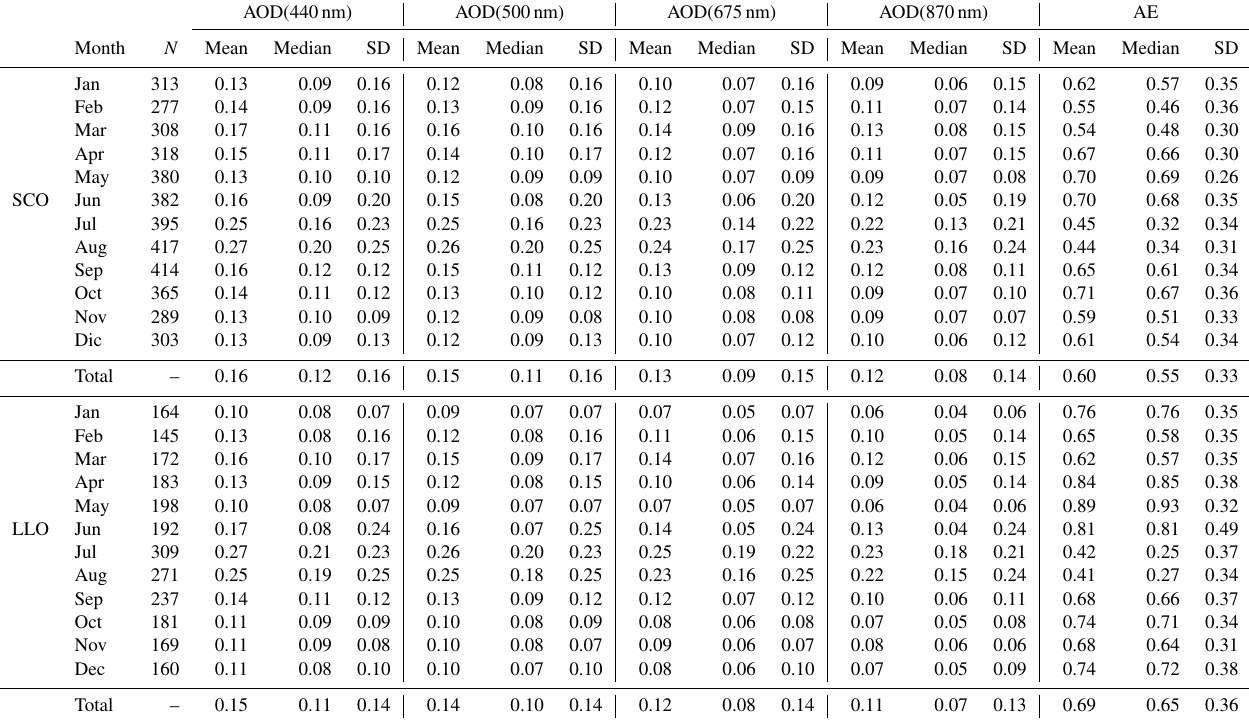
Table A1. Monthly mean, median and standard deviation (SD) of the aerosol optical depth (AOD) at 440, 500, 675 and 870nm and the Ångström exponent (AE 440 − 870nm ) at SCO from April 2005 and December 2020 and at LLO between July 2006 and December